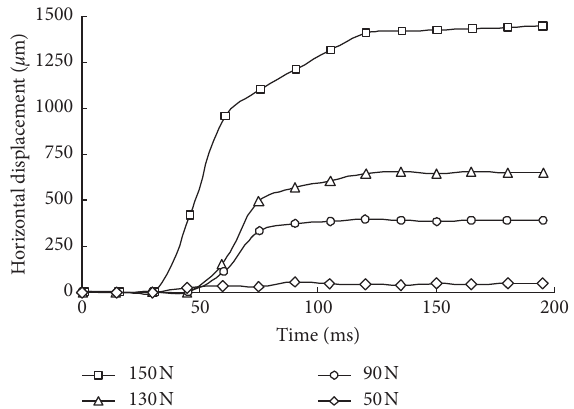
Figure 4: Horizontal displacement-time history curve of the working block under different vertical impact energies.